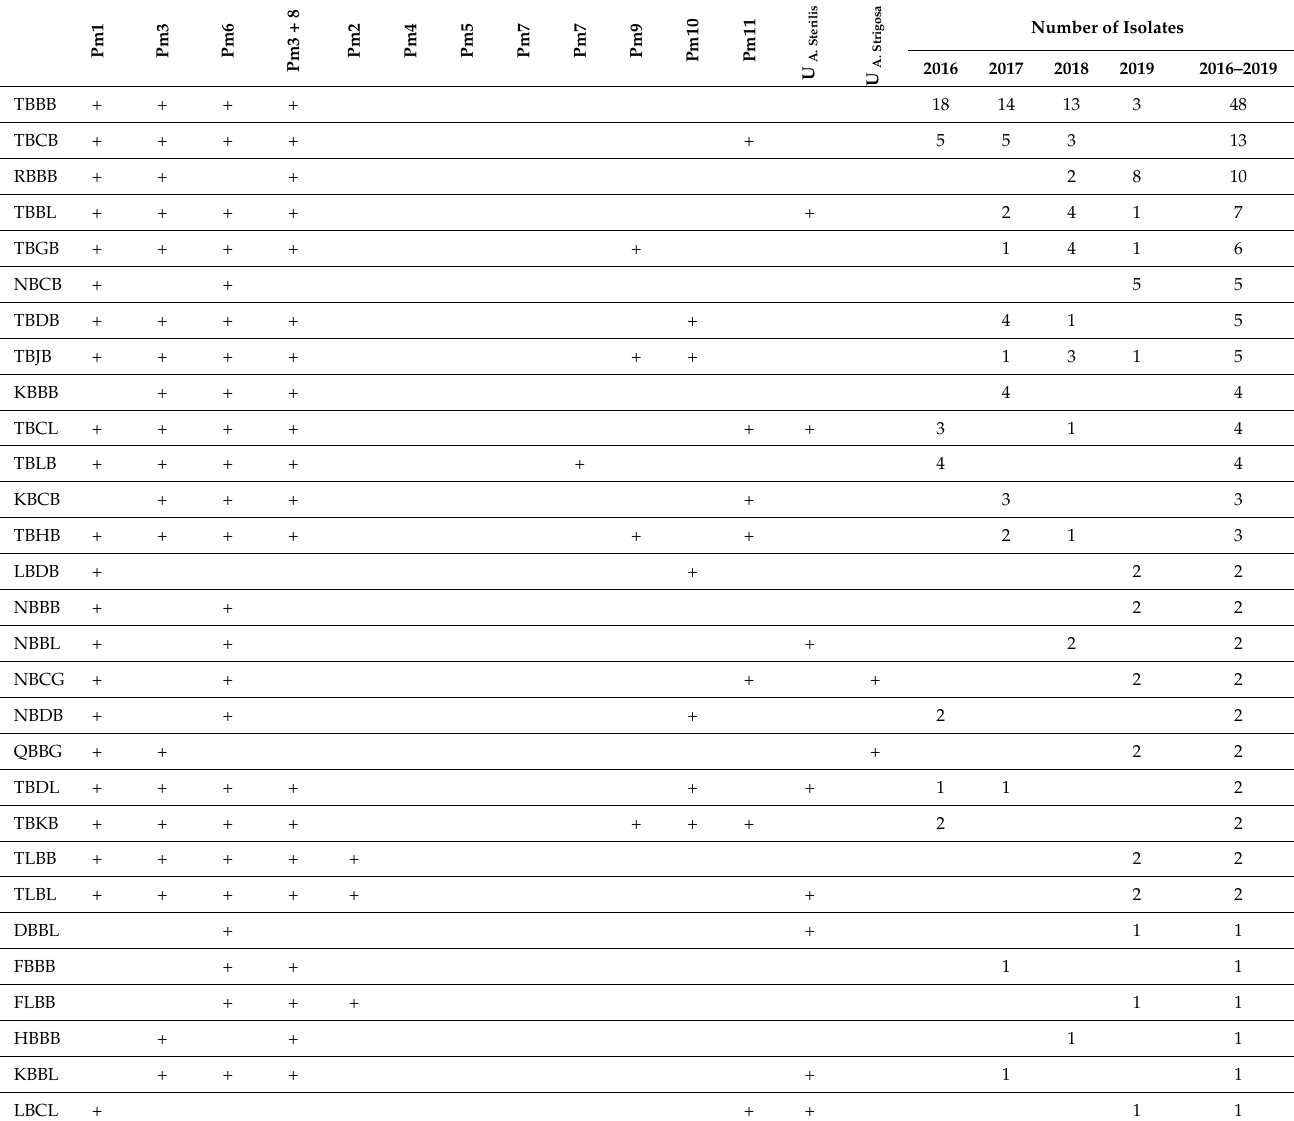
Table 4. Virulence spectra of 46 pathotypes of Blumeria graminis f.sp. avenae